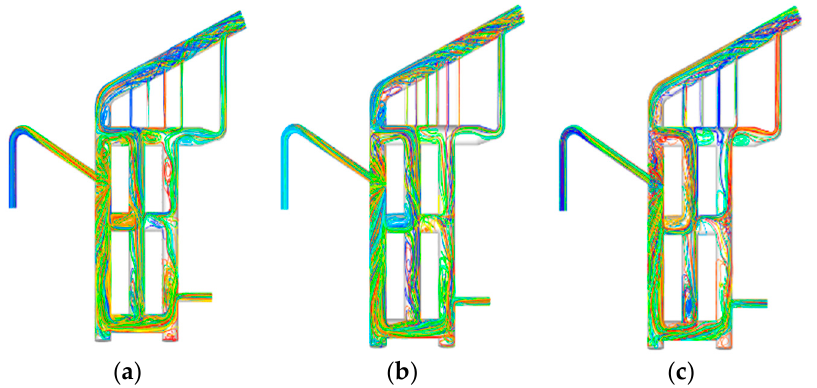
Figure 9. Flow field characteristics with different parameters of secondary separation tube